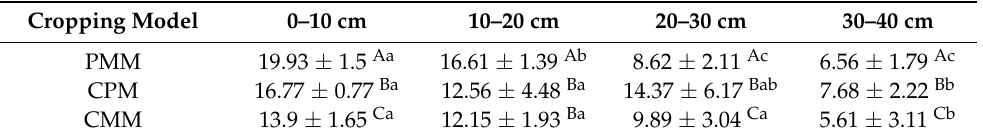
Table 1. Soil organic carbon (g.kg -1 ) content at different soil depths in C. oleifera mono-cropping model (CMM), peanut mono-cropping model (PMM), and Camellia–peanut inter-cropping model (CPM). Cropping